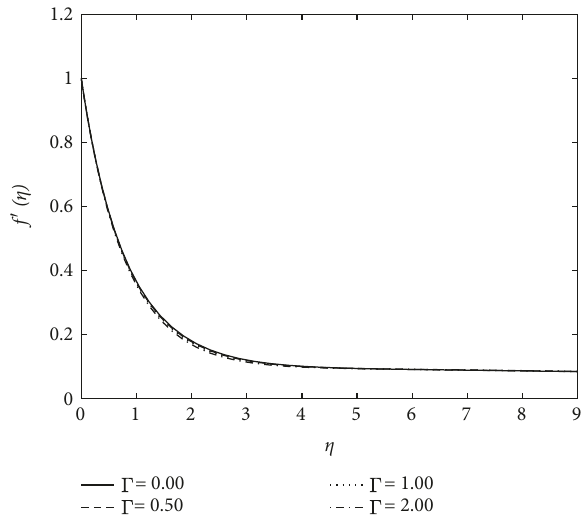
Figure 2: Change in the value of f